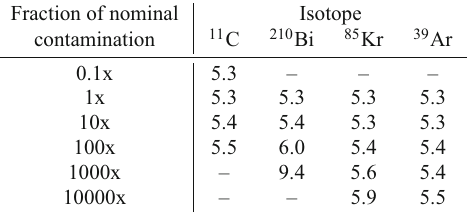
Table 9 Fit uncertainty on the CNO neutrino flux for 5 years of data with the baseline detector configuration as a function of isotope con- tamination level relative to baseline background level. For 210 Bi this is the level of the out-of-equilibrium component in water relative to the out-of-equilibrium level in scintillator. For 85 Kr and 39 Ar this is the level of contamination in water relative to baseline